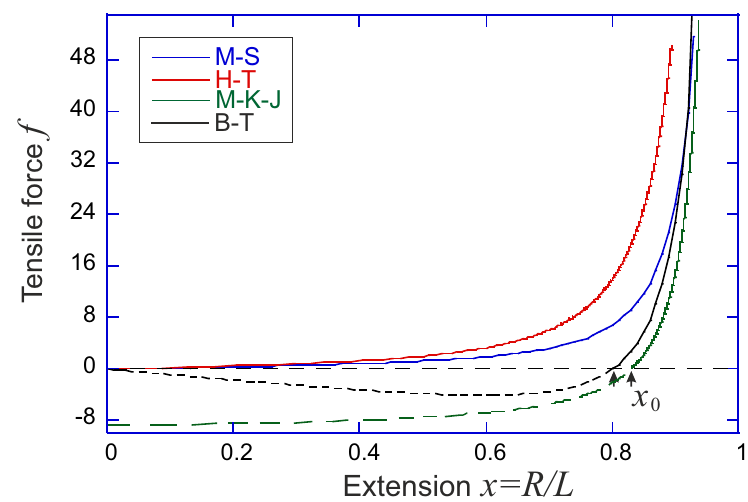
Figure 3. Comparison of tensile force f (plotted in units of k B T / l p ) against the filament extension factor x = R / L , for the Marko-Siggia, Ha-Thirumalai, MacKintoish-Käs-Janmey and Blundell-Terentjev models. In all cases the filament stiffness is such that L = l p (although the M-S model does not depend on this ratio). Dashed lines of the M-K-J and B-T models show the outward force in the compression regime with x < x 0 (the effect of zero force at x = 0, in the full closed loop configuration of an elastica of the B-T model is because the force in Equation (12) is defined along the tangent of the first/last monomer); the H-T model does not predict a zero-force average filament extension, and therefore has no compression